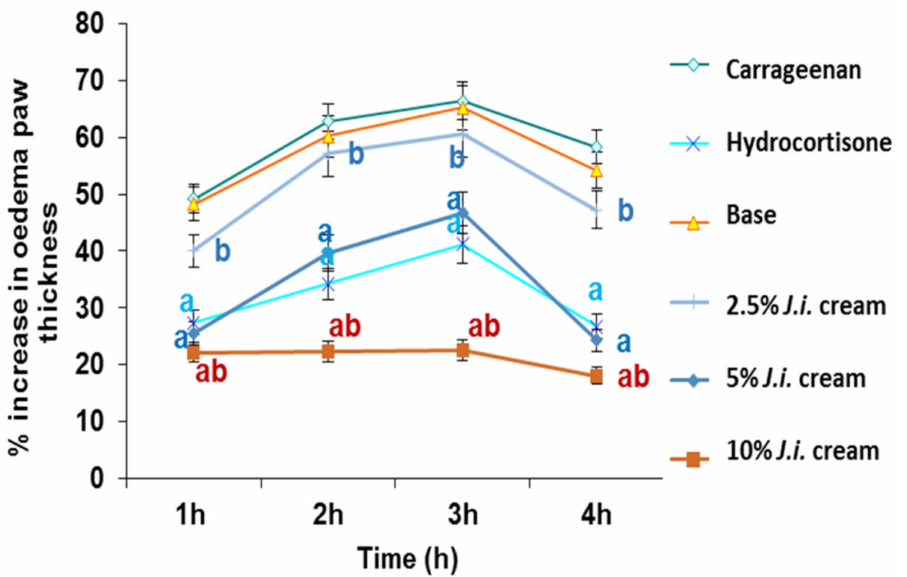
Figure 3. Effect of topical administration of Jatropha integerrima cream on edema volume in rat hind paw model. One way ANOVA and Fishers LSD comparison test* were used in data analysis, p < 0.05; a significantly different from carrageenan control value at respective time point. b significantly different from hydrocortisone group value at respective time